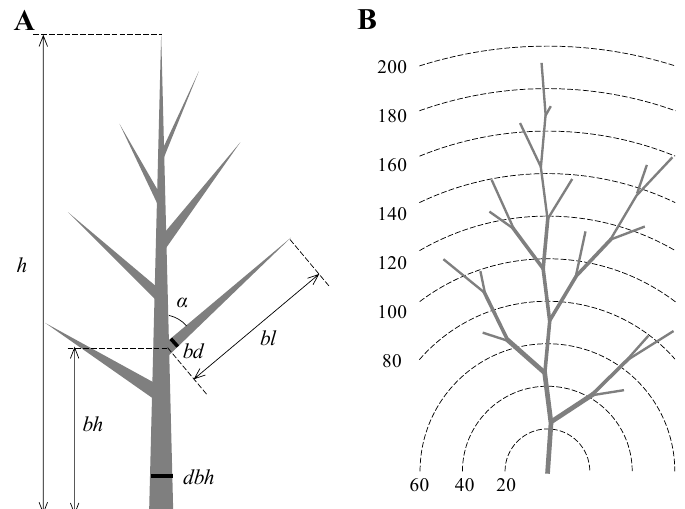
Figure 1. Illustration of ( A ) the measurements made for each sample tree before felling, and ( B ) for individual branch measurements. dbh = diameter at breast height, h = tree height, bh = branch height at the stem, bd = branch base diameter, bl = branch length, and α = vertical branch angle.